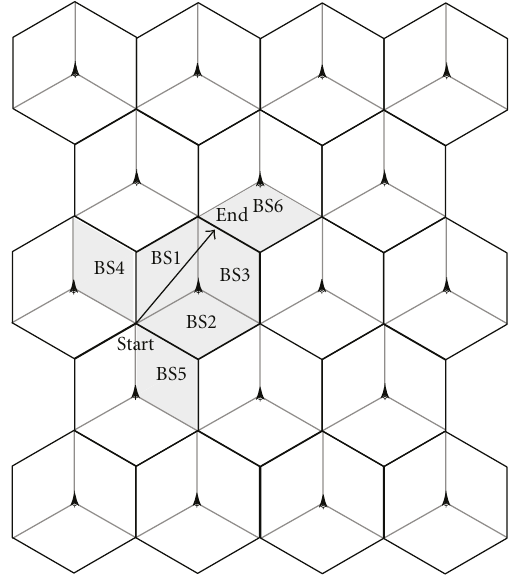
Figure 11: Route of the moving UE according to the